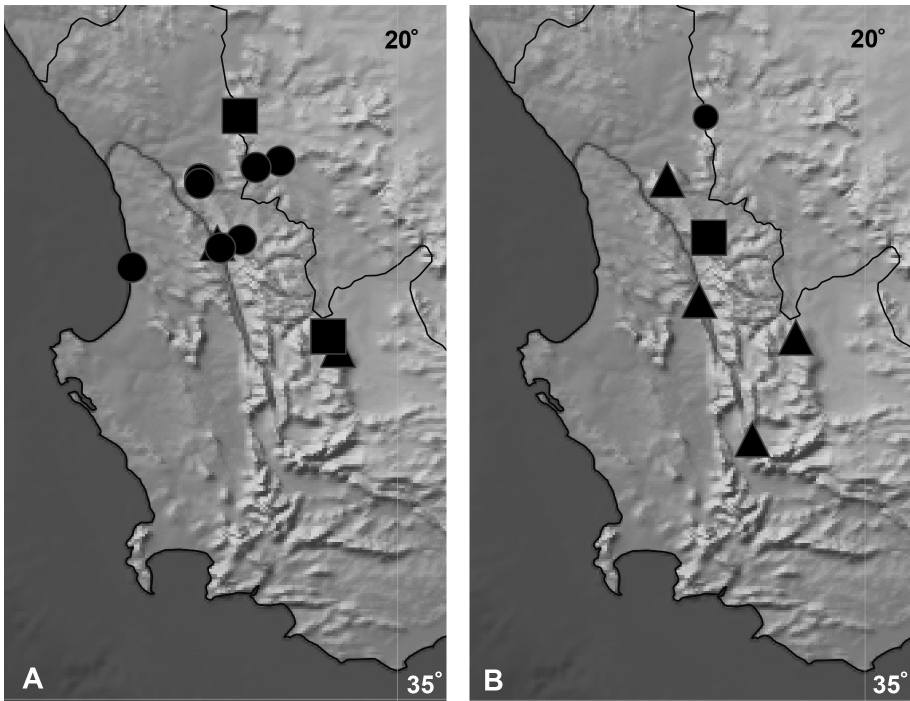
Figures 20. Gibbasilus maps of distribution. A arenaceus ( ● ), centrolobus ( ■ ), crinitus sp. n. ( ▲ ) B al- boala ( ● ), brevicolis ( ■ ), condylus sp. n. ( ▲